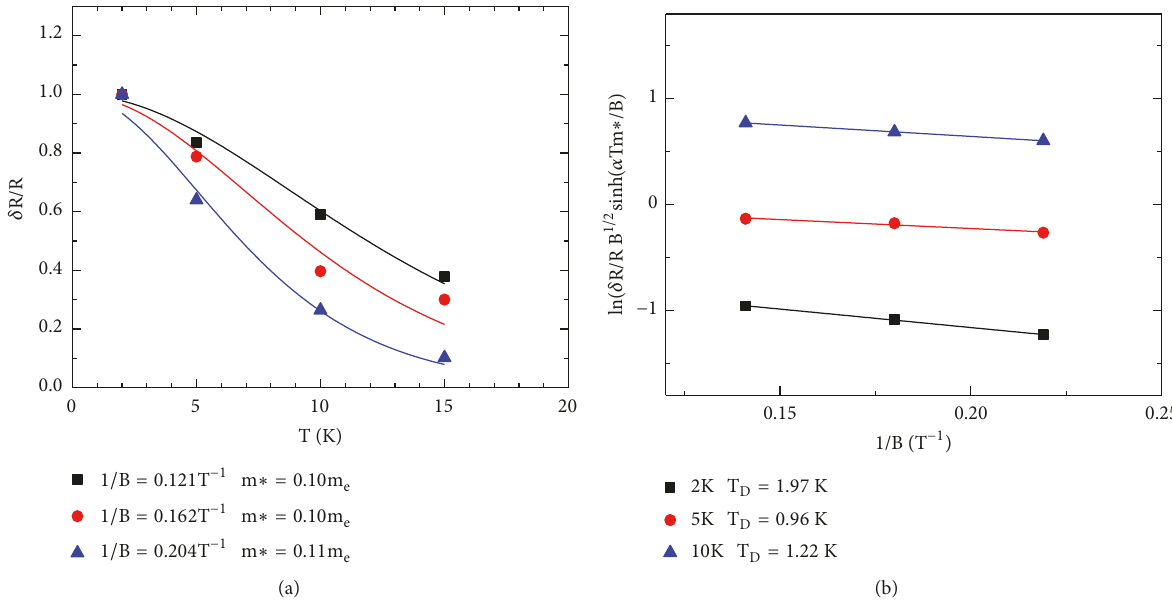
Figure 3: Results of fitting the SdH oscillations in the MR with the Lifshitz–Kosevich theory. (a) Temperature dependence of the SdH oscillation amplitude 𝛿 R / R at B = 8.26 T, 6.17 T, and 4.9 T. (b) Dingle plot at T = 2 K, 5 K, and 10